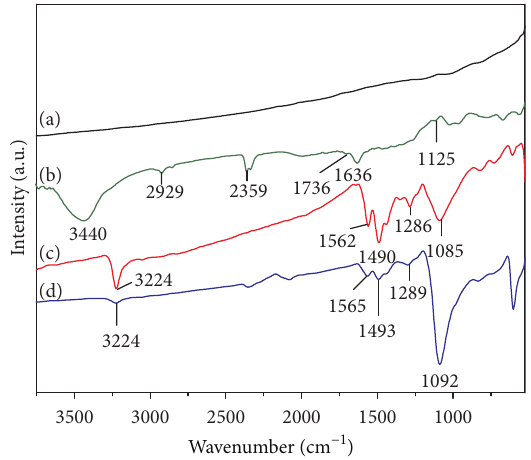
Figure 3: FTIR spectra of bare CNTs (a), CNT-COOH (b), pure PANI (c), and CNT/PANI composites prepared in HCl medium (d).